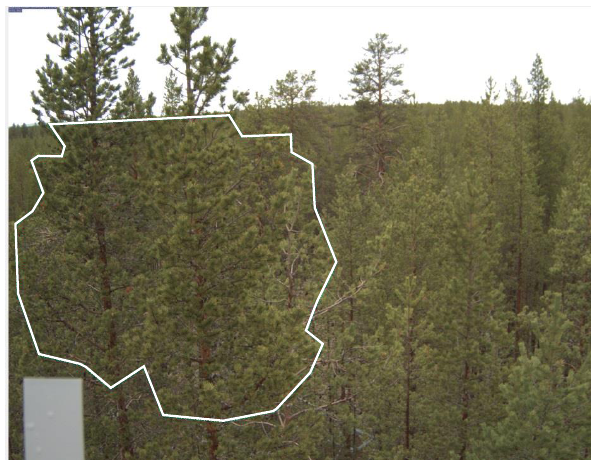
Figure 2. View from the pine forest crown camera. The line indi- cates the region of interest.